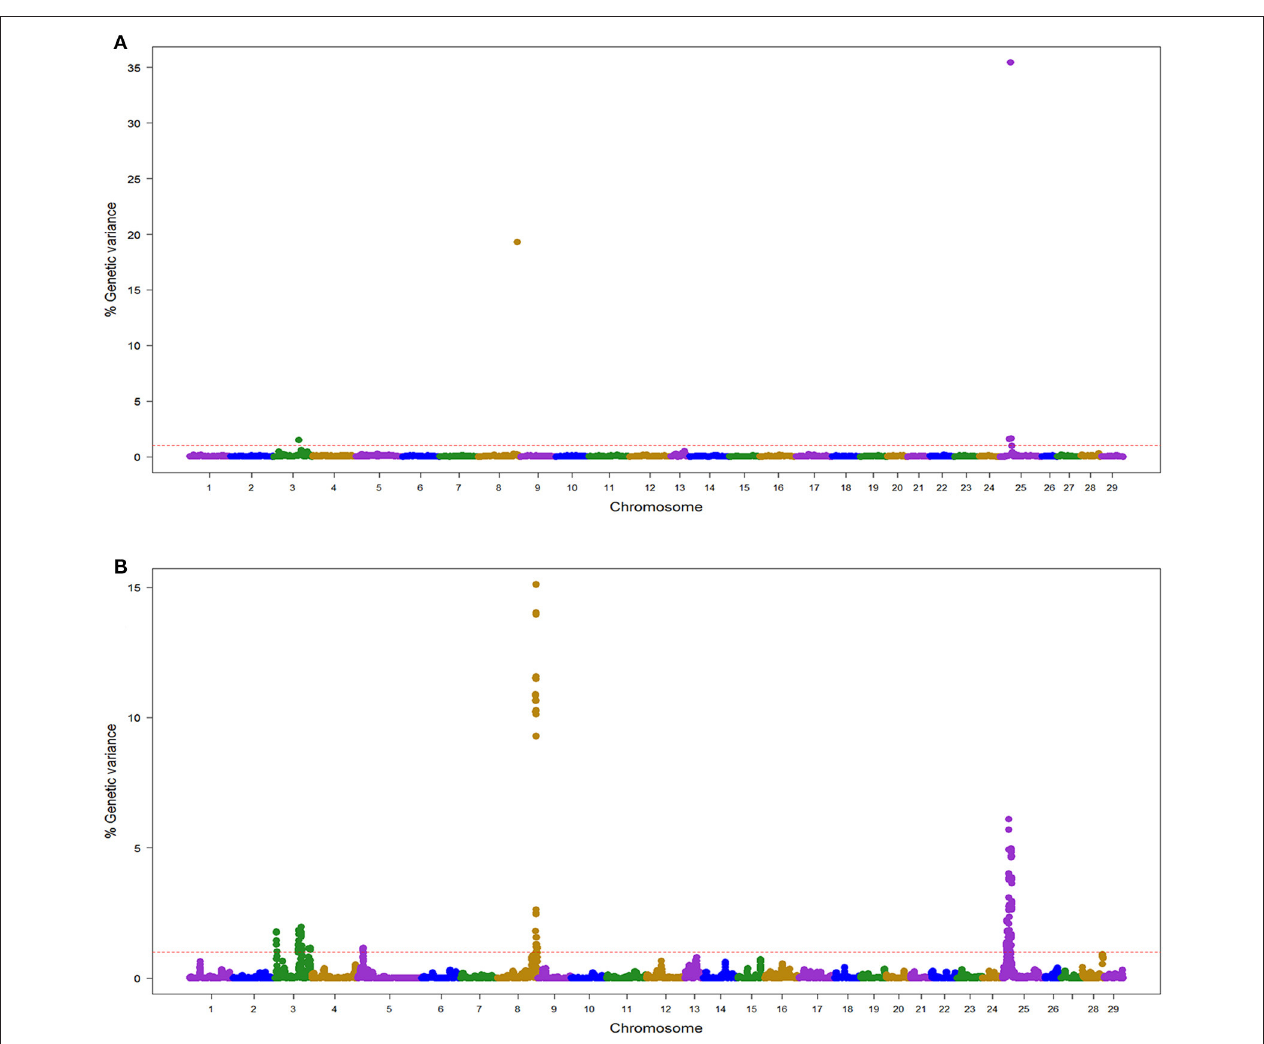
FIGURE 1 | Manhattan plot showing the association between SNP genomic windows and BCWD resistance in TLUM sample genotyped with 57K Chip-SNP: (A) GWAS for STATUS performed with BayesB using 1Mb exclusive windows. (B) GWAS for STATUS performed with wssGBLUP using 1Mb sliding